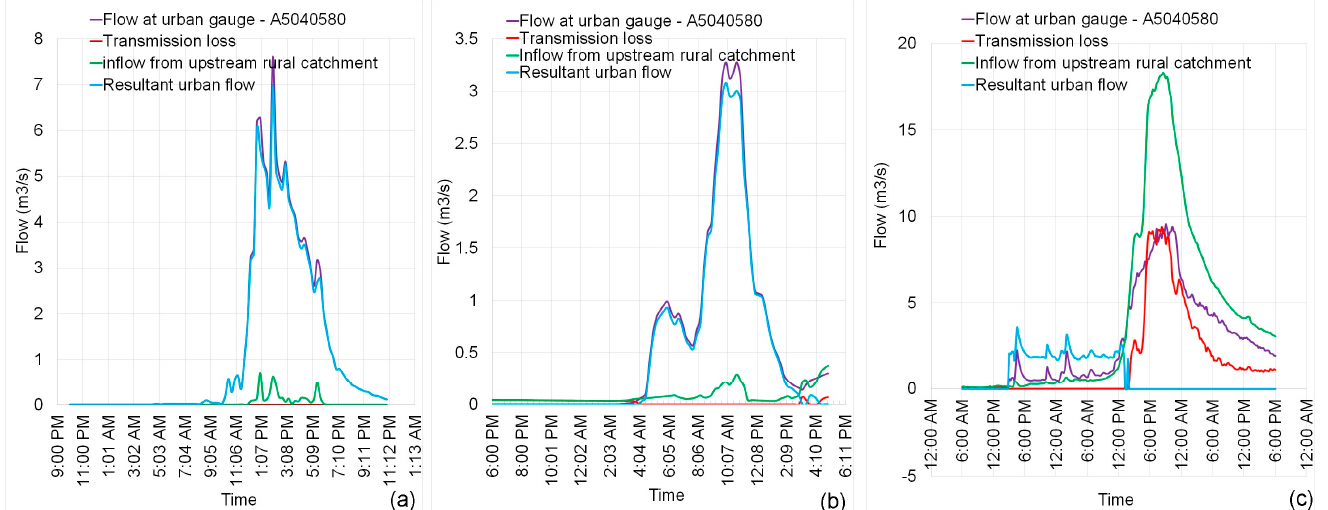
Figure 8 . Box plot of ( a ) IL ( b ) PL for rural portion .